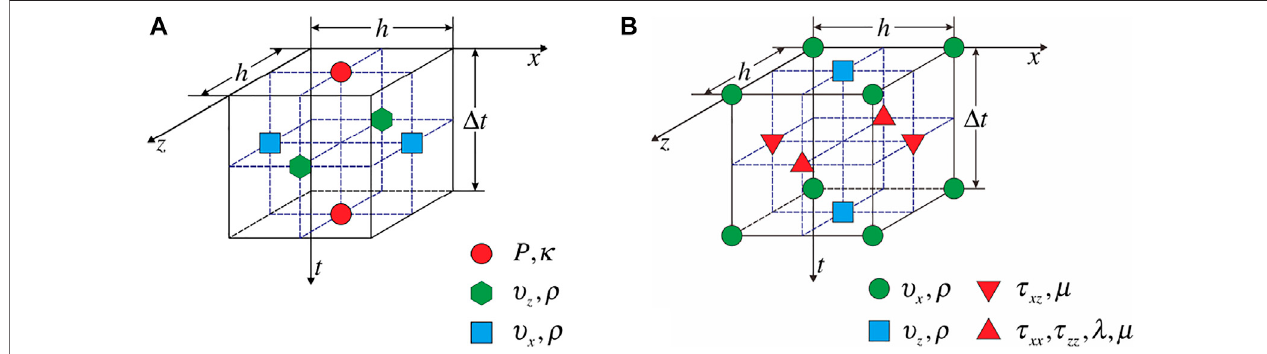
FIGURE1| Schematicrepresentationoftherelativepositionofthewave- fi eldvariablesandelasticparametersin (A) acousticwaveand (B) elasticwavestaggered- grid FD schemes.